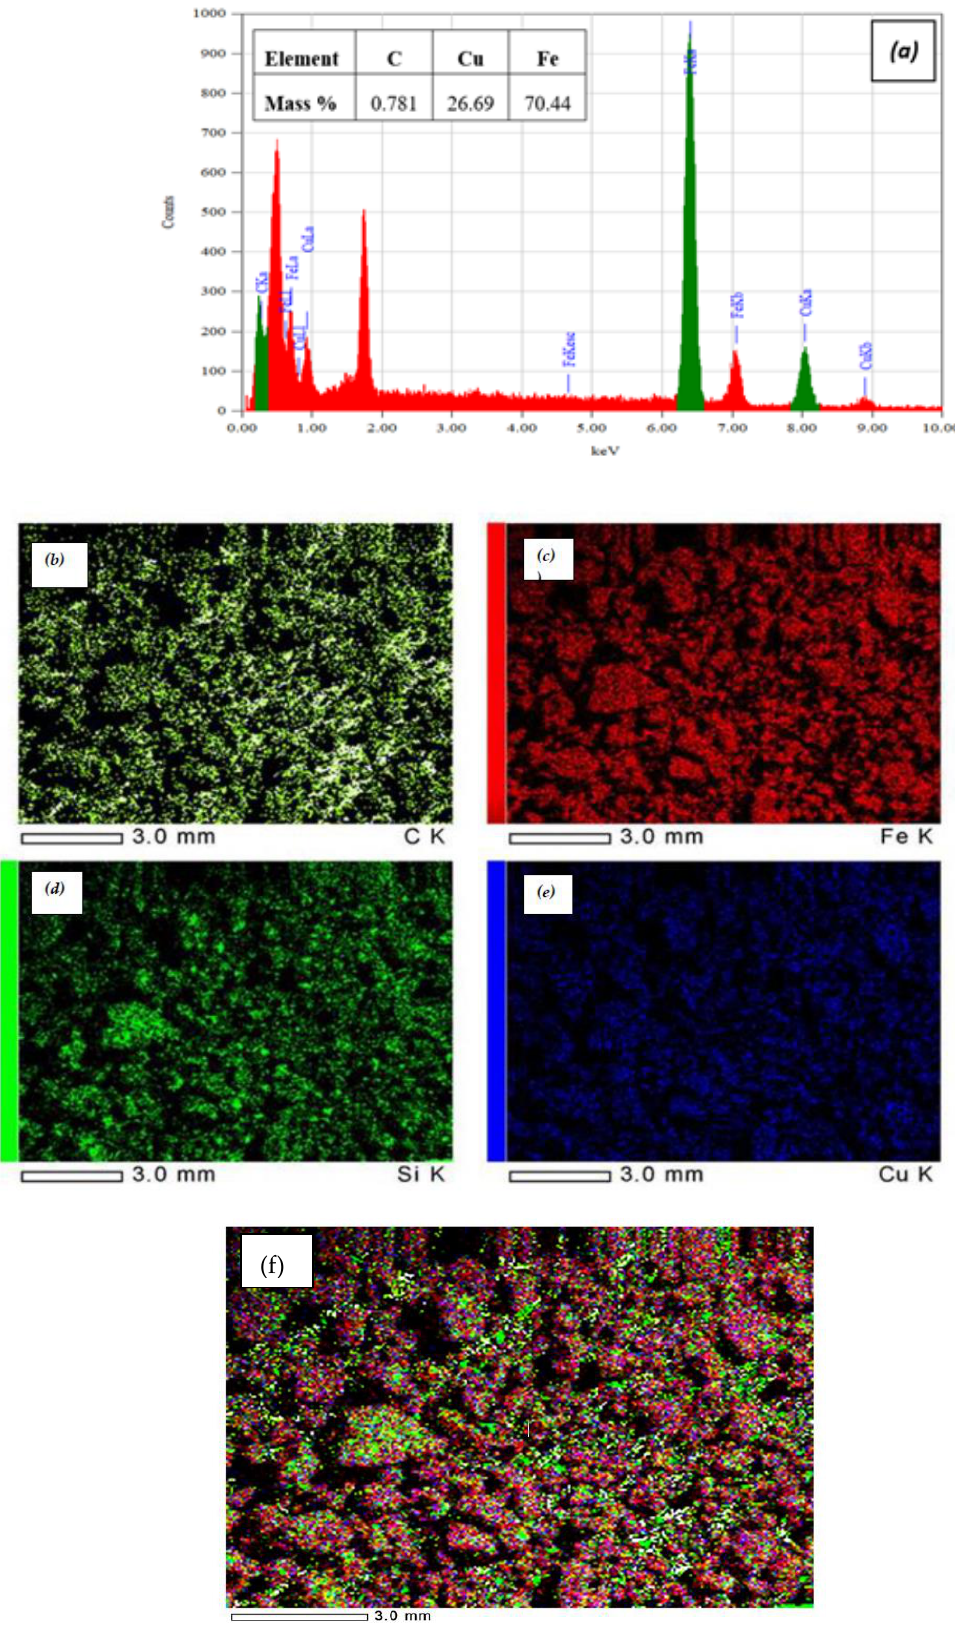
Figure 4. EDX analysis of LCF sample: ( a ) elemental analysis; ( b ) C; ( c ) Fe; ( d ) Si; ( e ) Cu; ( f ) mapping of the LCF.